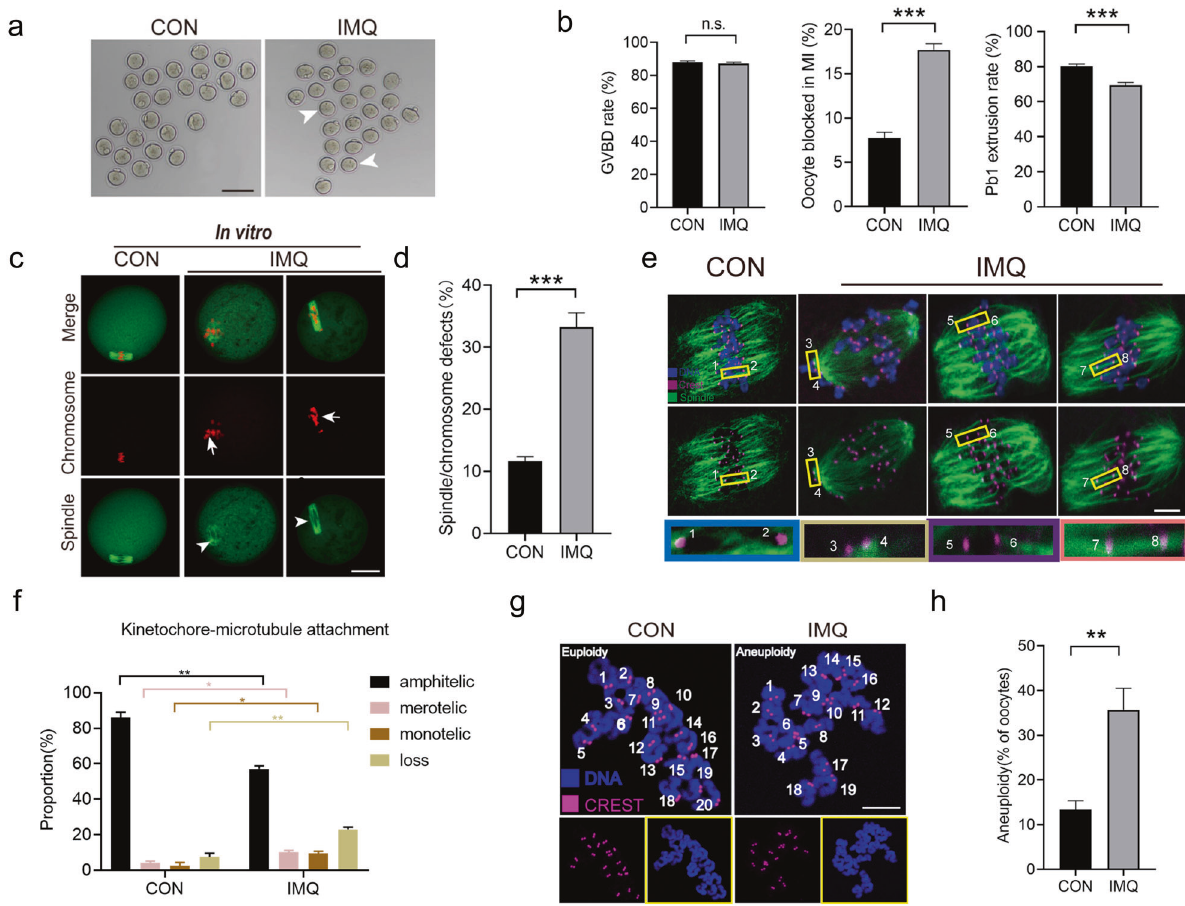
Fig. 3 Oocyte maturation and morphological analysis of meiotic apparatus. a Representative images of CON and IMQ oocytes. Failure to extrude Pb1 is marked with the white arrowhead. Scale bar: 200 µm. b Mensurable analysis of the rate of GVBD, Pb1 extrusion and arrested at MI stage of CON ( n = 150) and IMQ ( n = 165) oocytes. In the oocytes from IMQ and CON group, the spindle was stained green by α -tubulin antibody and the chromosomes were counterstained red by PI. c Confocal images of spindle morphology and chromosome alignment in the CON and IMQ oocytes that matured in vitro. Arrows point to the disorganized spindles and arrowheads indicate the misaligned chromosomes. Scale bar: 30 µm. d Quantitative analysis of 123 CON and 130 IMQ oocytes that matured in vitro with spindle defects and chromosome disalignment. e Characteristic confocal images of kinetochore-microtubule attachments are displayed. The kinetochores were dyed purple by CREST antibody. The microtubules were stained green by the anti-tubulin antibody. The chromosomes were dyed blue by Hoechst 33342. Scale bar: 10 µm. Chromosomes labeled 1 and 2 represent examples of amphitelic attachment, chromosomes 3 and 4 represent examples of loss attachment, chromosomes 5 and 6 represent examples of monotelic attachment, chromosomes 7 and 8 represent examples of merotelic attachment. f Quantitative analysis of kinetochore-microtubule attachments in CON ( n = 76) and IMQ ( n = 88) oocytes. g Representative images of karyotype analysis from MII oocytes. Scale bar: 20 µm. h The proportion of aneuploidy in CON ( n = 96) and IMQ ( n = 121) oocytes. The data were shown as mean ± SD. * P < 0.05, ** P < 0.01, *** P <